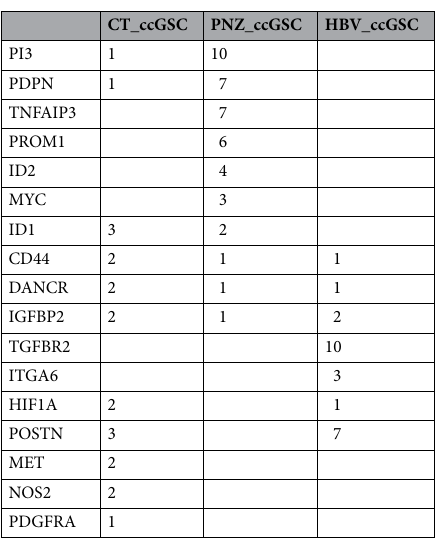
Table 1. ccGSC markers and the number of samples in each histological